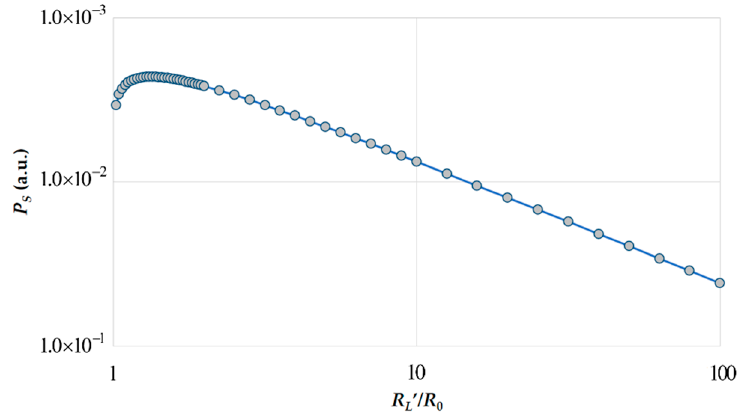
Figure 9. Power loss of the inductor under various impedance values.